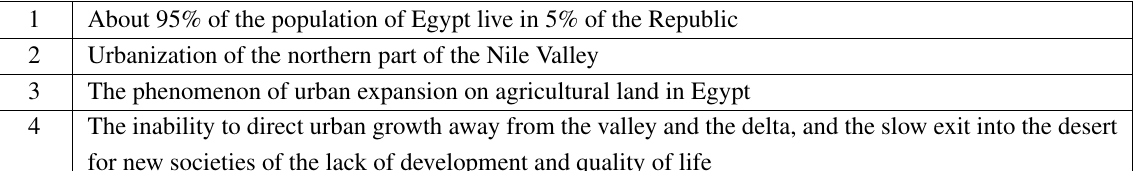
Table 7. The Challenges of developing new communities in